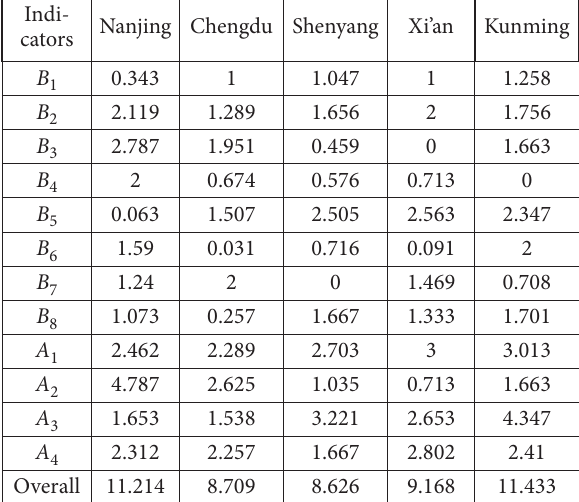
Table 7. Disaster prevention capability of urban park